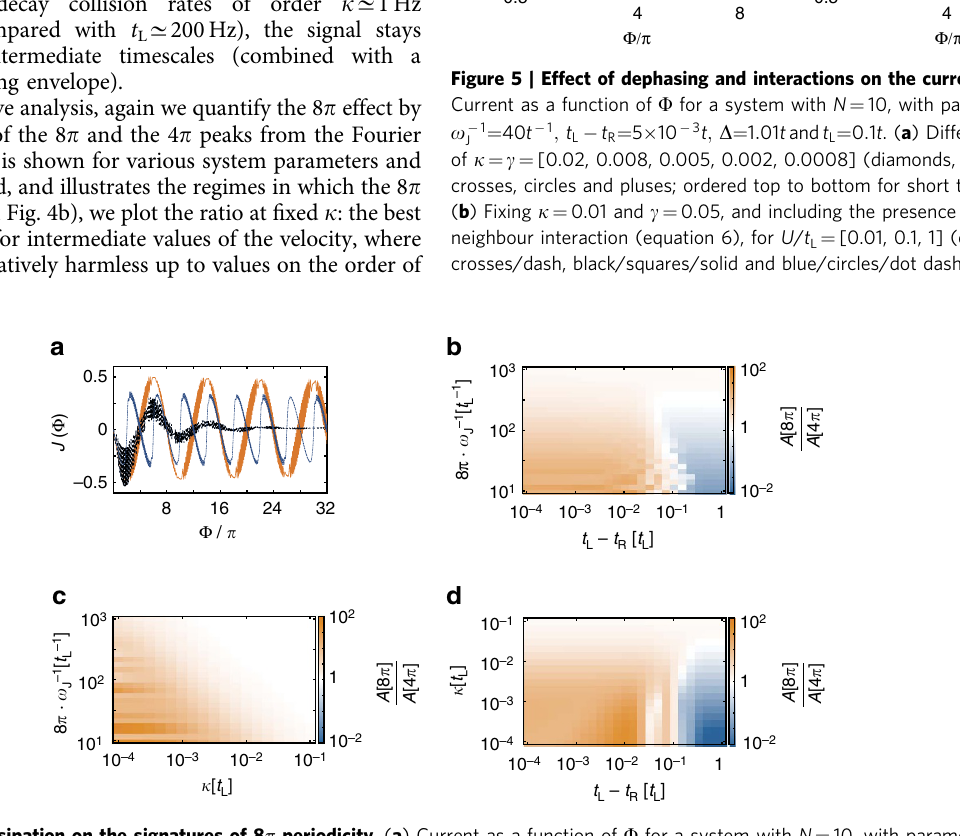
Figure 4 | Effect of dissipation on the signatures of 8 p periodicity. ( a ) Current as a function of F for a system with N ¼ 10, with parameters 10 t (cid:2) 1 and k ¼ 10 (cid:2) 4 t L , and t L (cid:2) t R ¼ 10 (cid:2) 2 t L (orange, solid), k ¼ 5 (cid:4) 10 (cid:2) 3 t L , t L (cid:2) t R ¼ 10 (cid:2) 2 t L (black, dot dash), k ¼ 10 (cid:2) 4 t L and t L (cid:2) t R ¼ t L 8 p (cid:4) o (cid:2) 1 J ¼ L (blue, dash). ( b – d ) Ratio of the strength of the 8 p peak of the FFT of the current profile A 8 p ½ (cid:3)ð Þ and the 4 p peak A 4 p ½ (cid:3)ð Þ with k ¼ 10 (cid:2) 3 t L fixed 10 t (cid:2) 1 fixed ( d ). ( b ) t L (cid:2) t R ¼ 10 (cid:2) 2 t L fixed ( c ) and 8 p (cid:4) o (cid:2) 1 J ¼ L NATURE COMMUNICATIONS|7:12280|DOI: